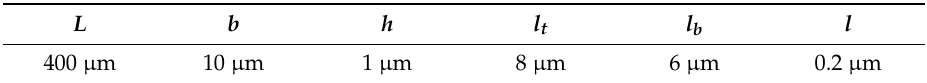
Table 3. Geometric parameters of the FG micro-switch.